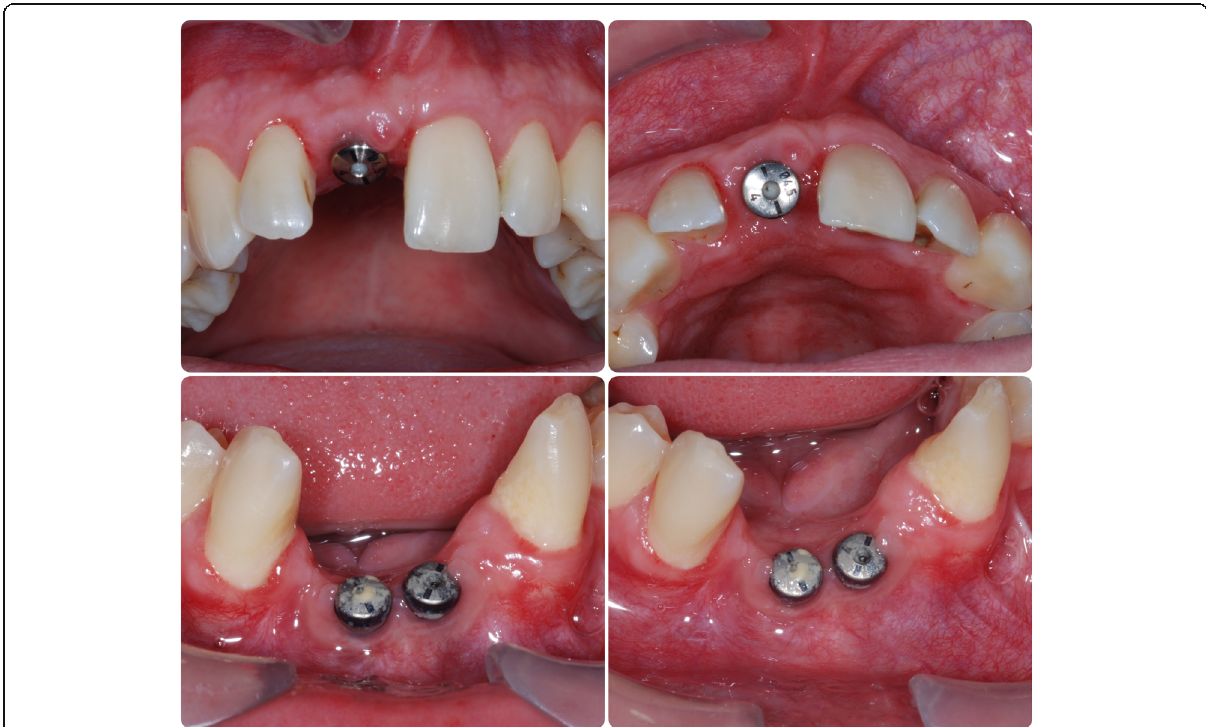
Fig. 4 Healing following fixture exposure. Fixtures following secondary surgery and connection of healing abutments in 11, 31 and 41 positions